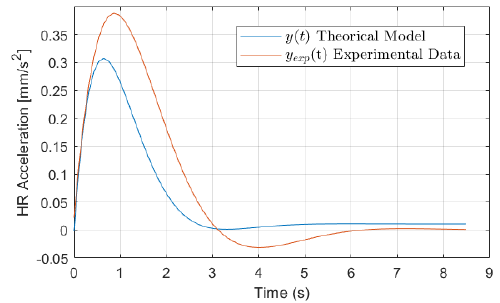
Figure 14. Response overlap plot.